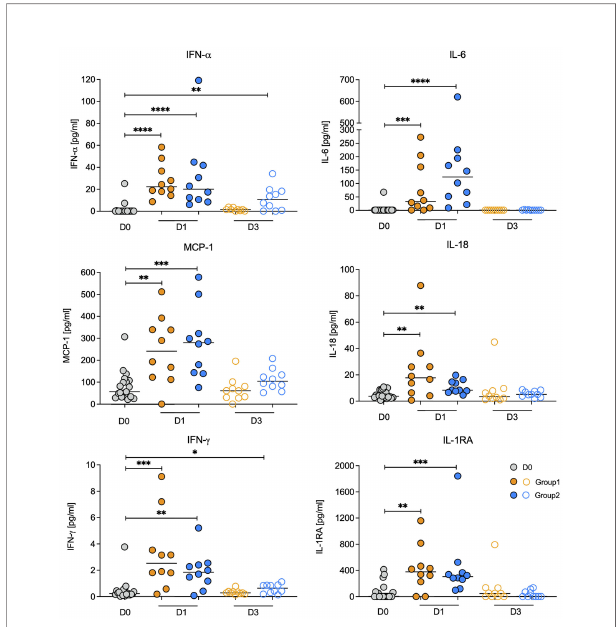
FIGURE 2 | Changes in plasma cytokine concentrations post vaccination. Plasma cytokine concentrations for IFN-a, IL-6, IL-18, IFN-g, MCP-1, and IL- 1RA on day 0 (vaccine prime; grey circles) and on days 1 ( fi lled circles) and day 3 (open circles) post vaccination for Group 1 (orange circles) and Group 2 (blue circles) animals. Note that D0 includes animals from both Group 1 and Group 2. Horizontal lines represent median values. Data between two time points were compared by Mann-Whitney test with *, **, ***, **** indicating p<0.05, p<0.01, p<0.001, or p<0.0001